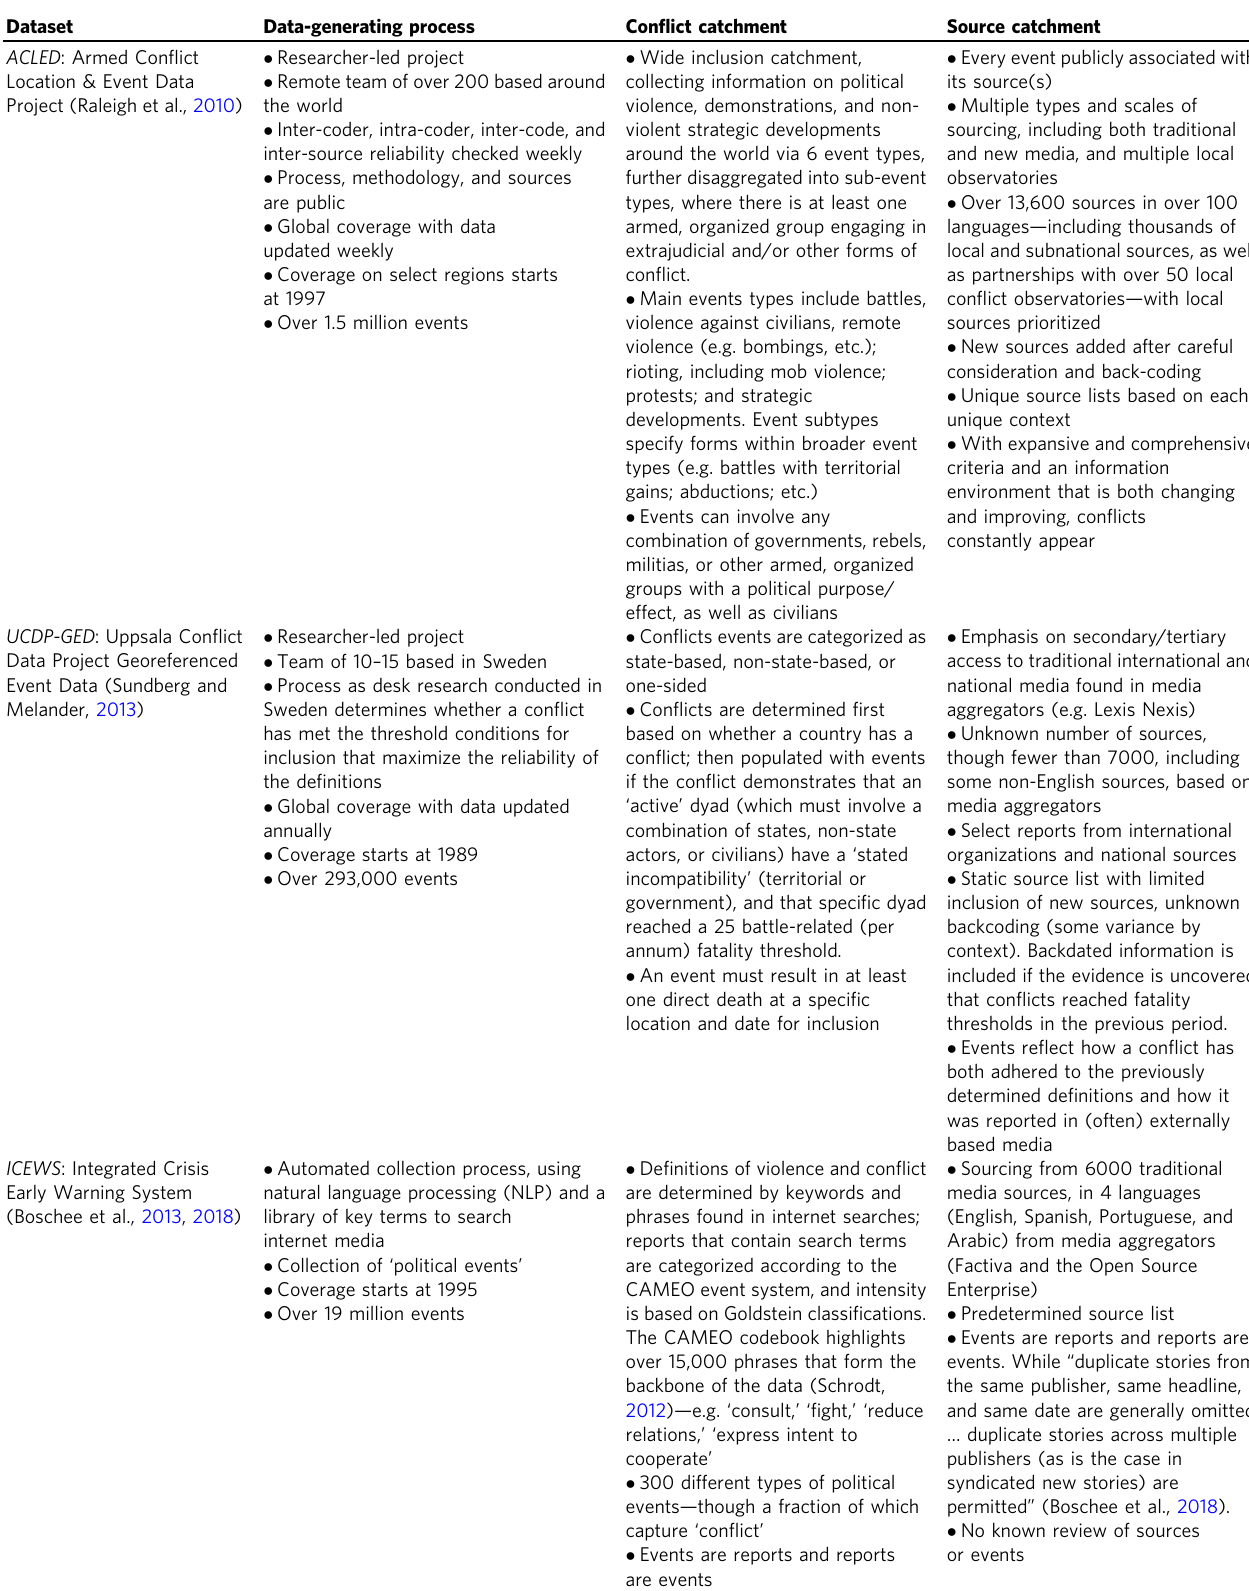
Table 1 Comparison of datasets based on information collection